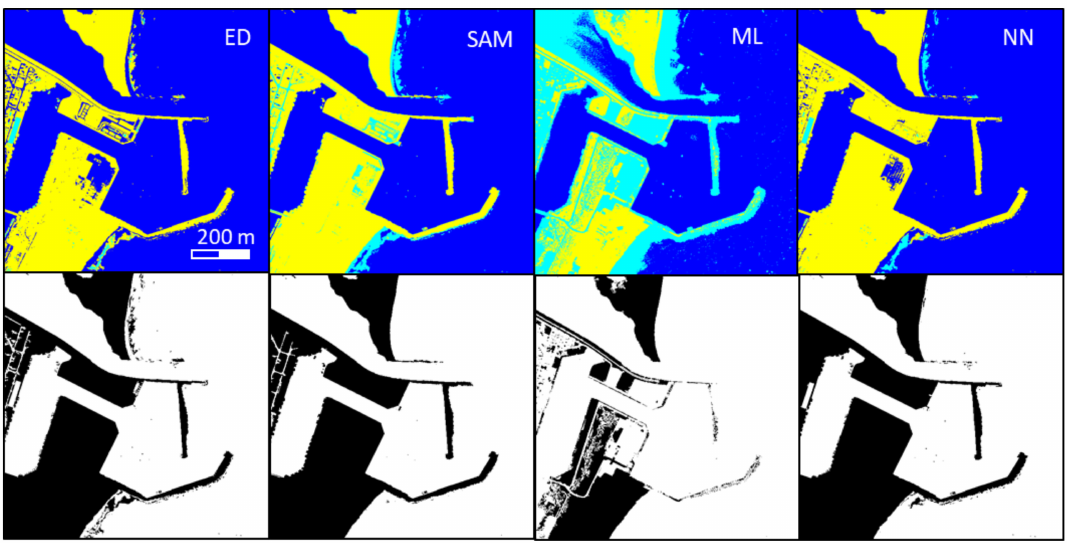
Figure 8. (Top panels) Pixel classification retrieved by the 4 methods described in Section 2 (ED, SAM, ML, NN) on 10 August 2010 for the northern area (Figure 1); 3 classes were used: land (yellow), foam (light blue) and water (blue). (Bottom panels) Land / ocean maps obtained after merging foam and water pixels using a segmentation